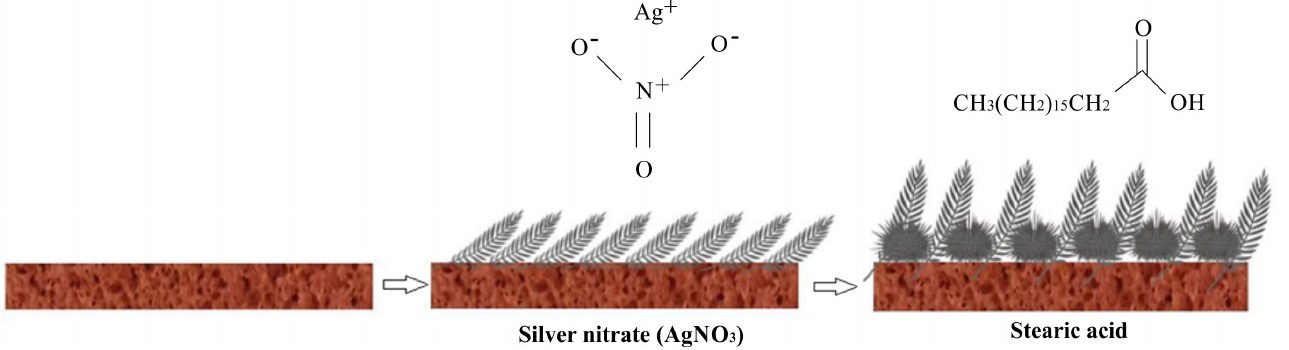
Figure 1. Schematic illustration of superhydrophobic copper foam production